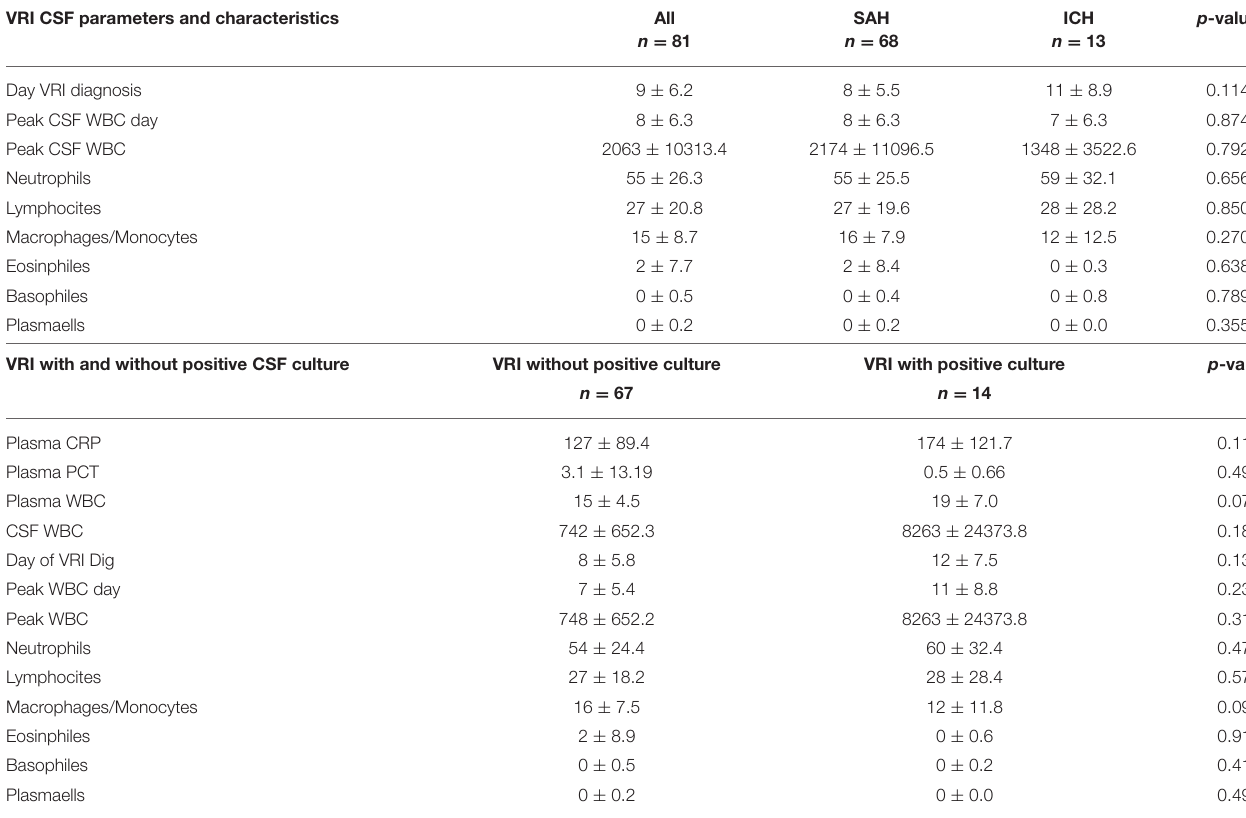
TABLE 3 | Subgroup analysis of patients with ventriculostomy-related infection (VRI). VRI CSF parameters and